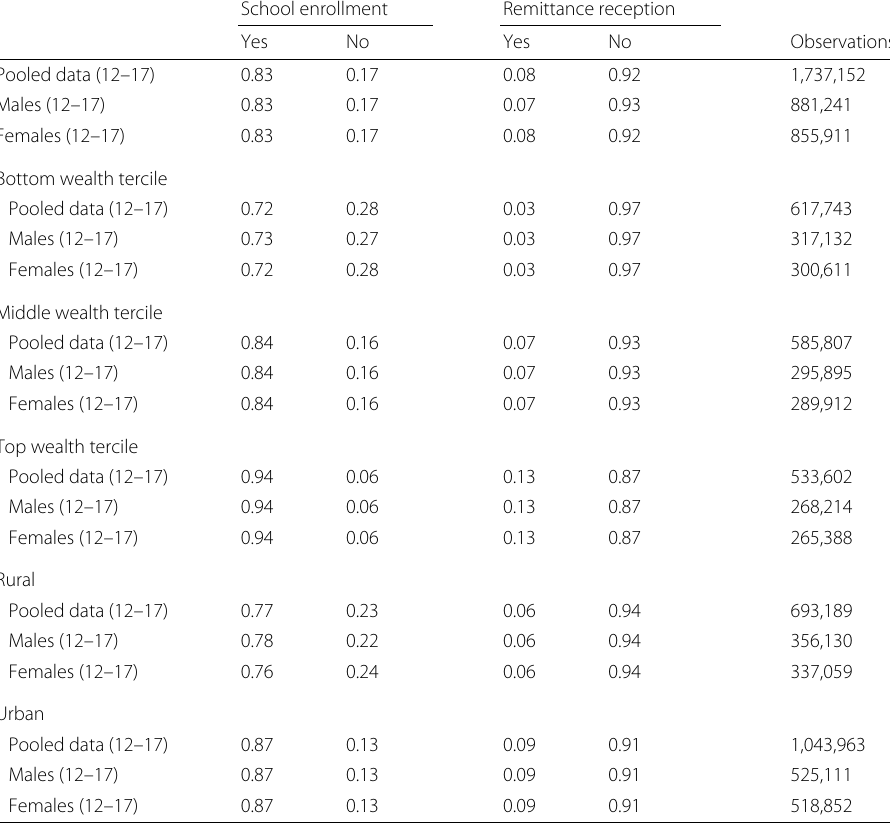
Table 9 Proportion of children who are enrolled in school and who receive remittances School enrollment Remittance reception